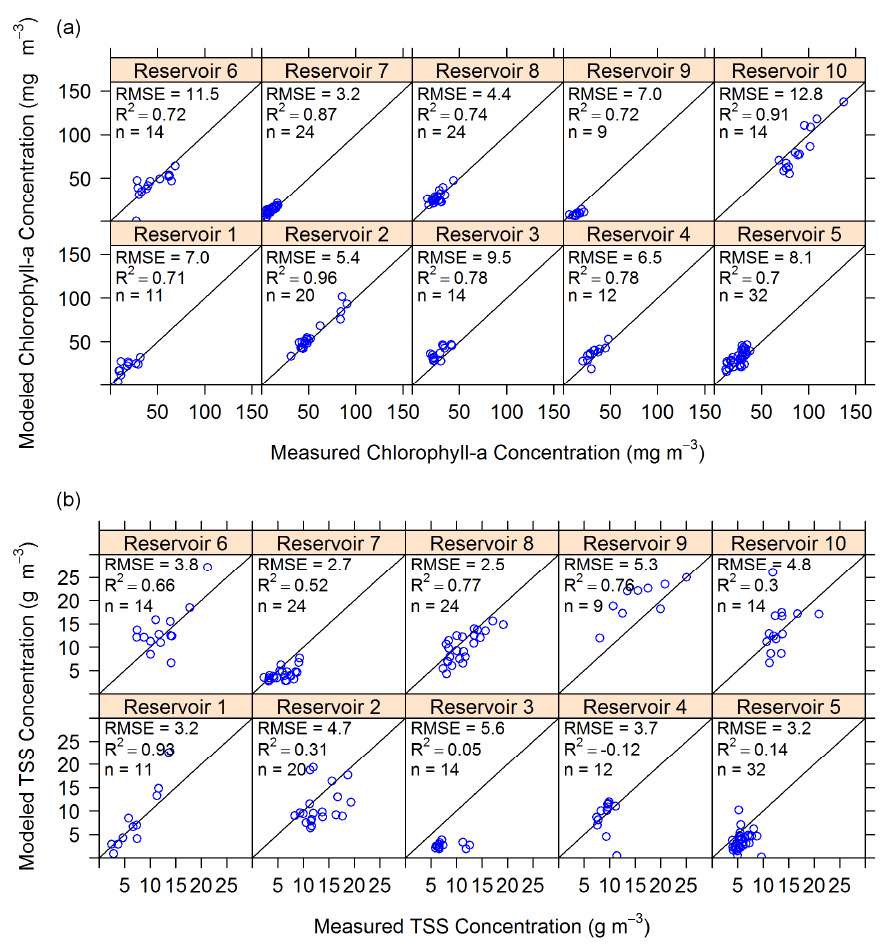
Figure 11. Algorithm results separated by reservoir, including estimates of ( a ) chl-a concentration and ( b ) TSS concentration. The thin black lines indicate 1:1 correspondence. RMSE is in mg ∙ m − 3 for chl-a concentration and g ∙ m − 3 for TSS concentration. n is the number of samples displayed in each sub-graph. R 2 is the coefficient of determination between modeled and measured values in each sub-graph.